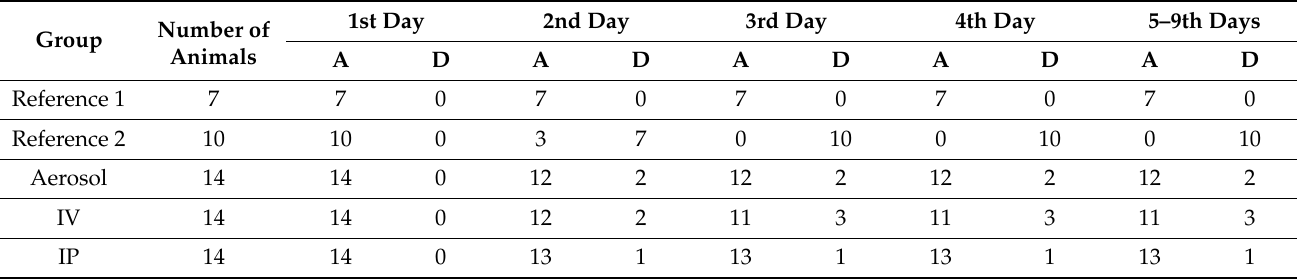
Table 6. Survival analysis of